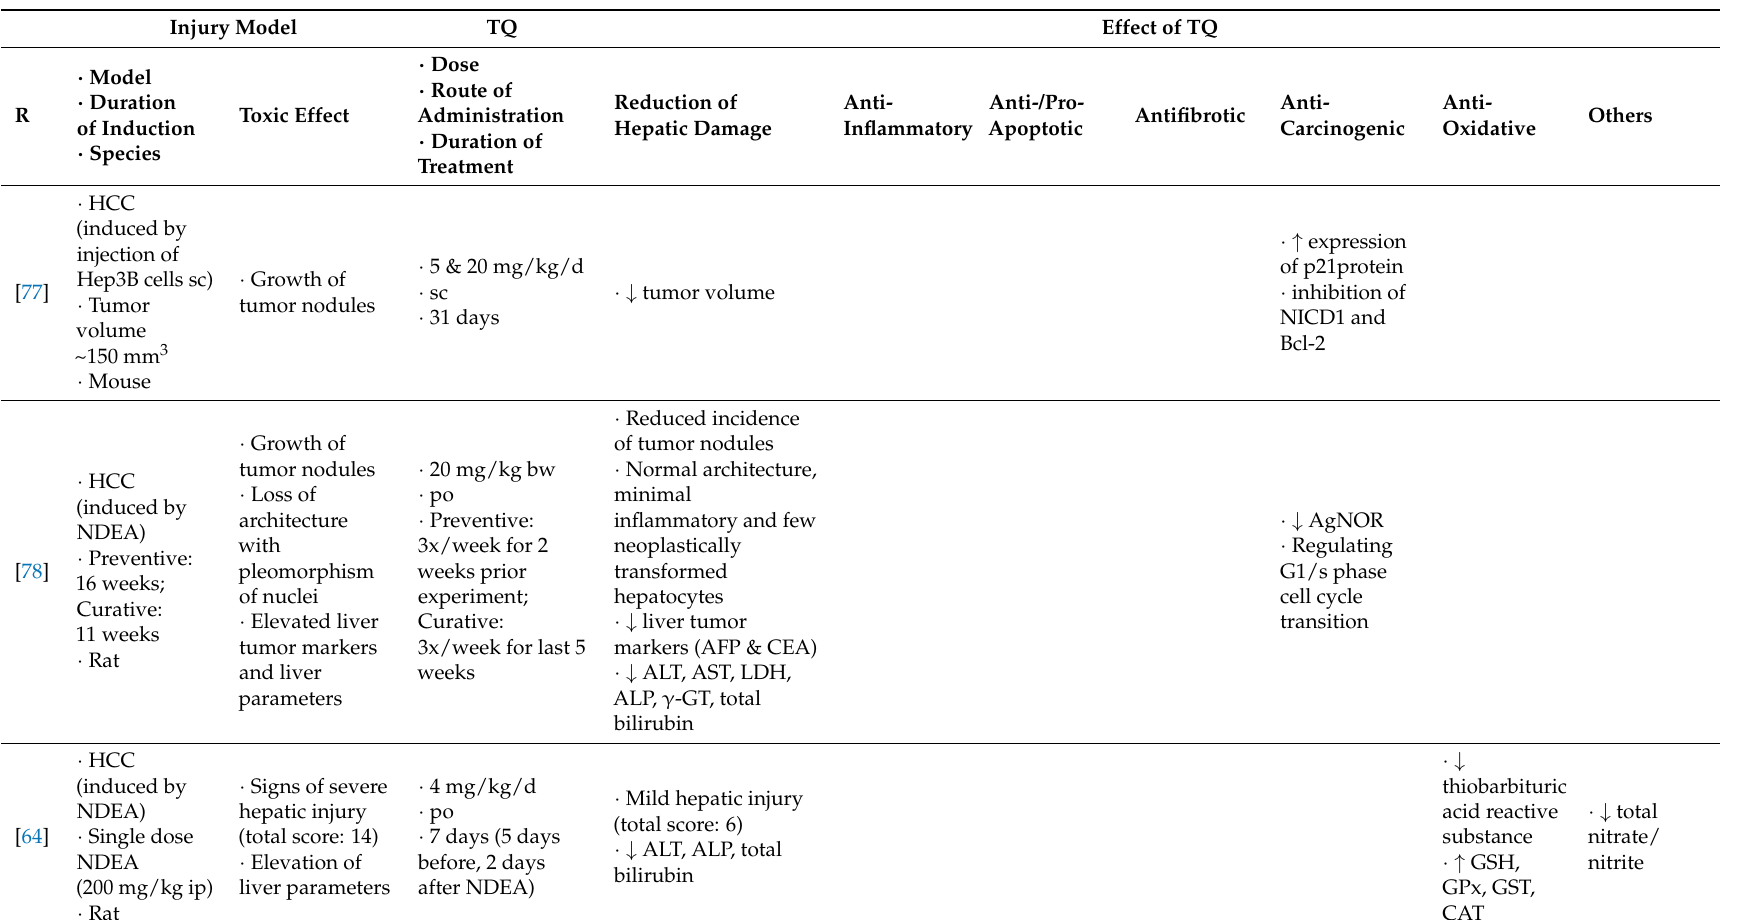
Table 6. Effects on liver injury caused by